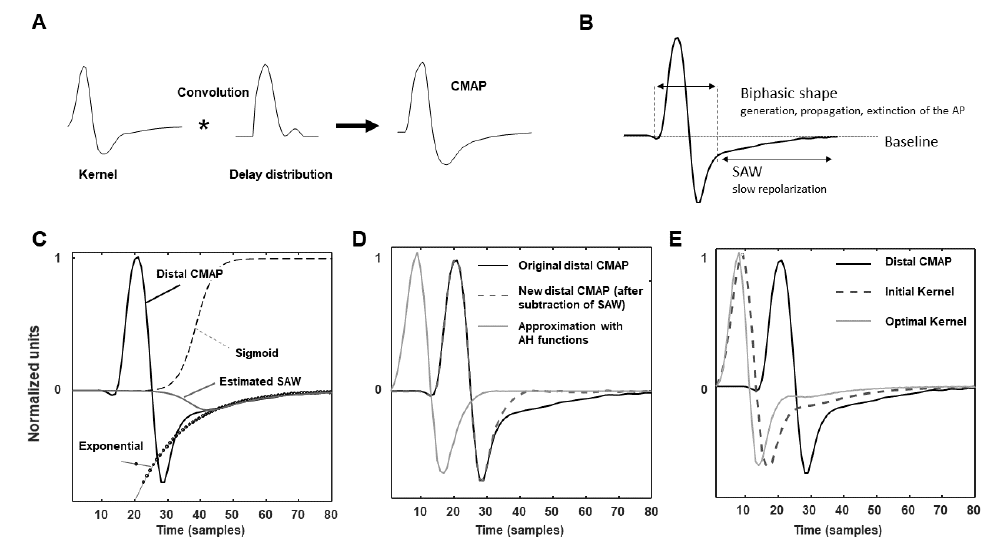
Figure 2. Representation of convolution (indicated by ∗ ) and example of kernel reconstruction, focusing on the slow afterwave (SAW). ( A ) A CMAP is represented as the convolution of a kernel and a delay distribution (both unknown). ( B ) Indication of the contribution of SAW in a CMAP. ( C – E ) Estimation of the kernel. ( C ) The SAW of the distal CMAP is estimated as the product of an exponential and a sigmoid function. ( D ) The estimated SAW is subtracted and the distal CMAP is reconstructed using AH functions (the reconstruction is time shifted for simpler representation). ( E ) The initial kernel is optimized to reduce the reconstruction error for the CMAP pair (including proximal and distal CMAP).